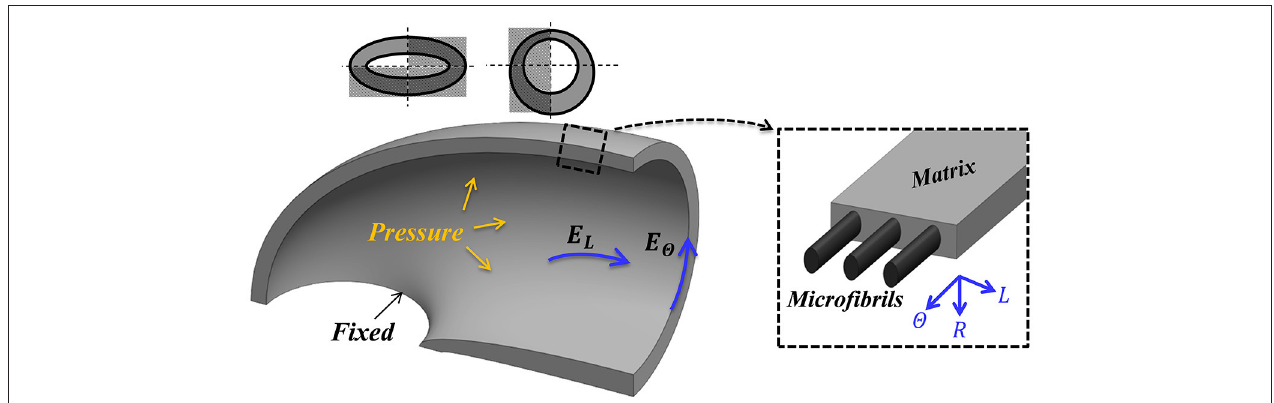
FIGURE 2 | Mechanical guard cell model. One quarter of a guard cell with two symmetry planes, a fixed base and a uniform internal pressure ( P ) is considered for the analysis. The guard cell wall is a composite of circumferentially oriented microfibrils and a matrix that is macroscopically characterized by three elastic moduli (longitudinal, circumferential and radial— E L , E 2 and E R , respectively).